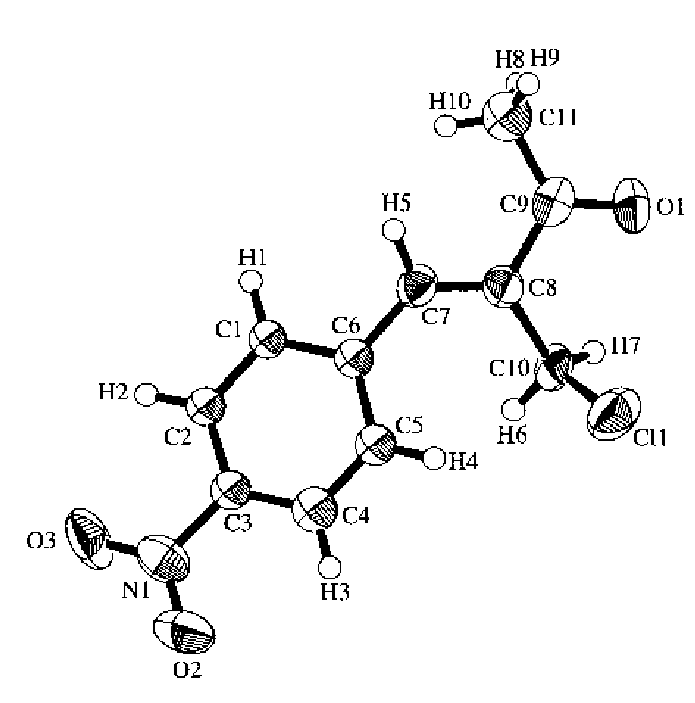
Figure 3: Crystal Structure of